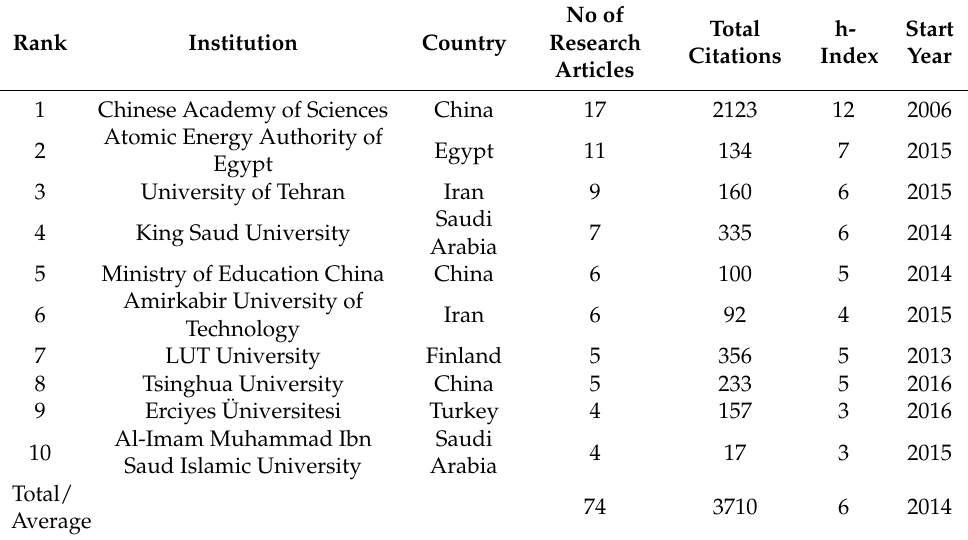
Table 4. Top 10 productive